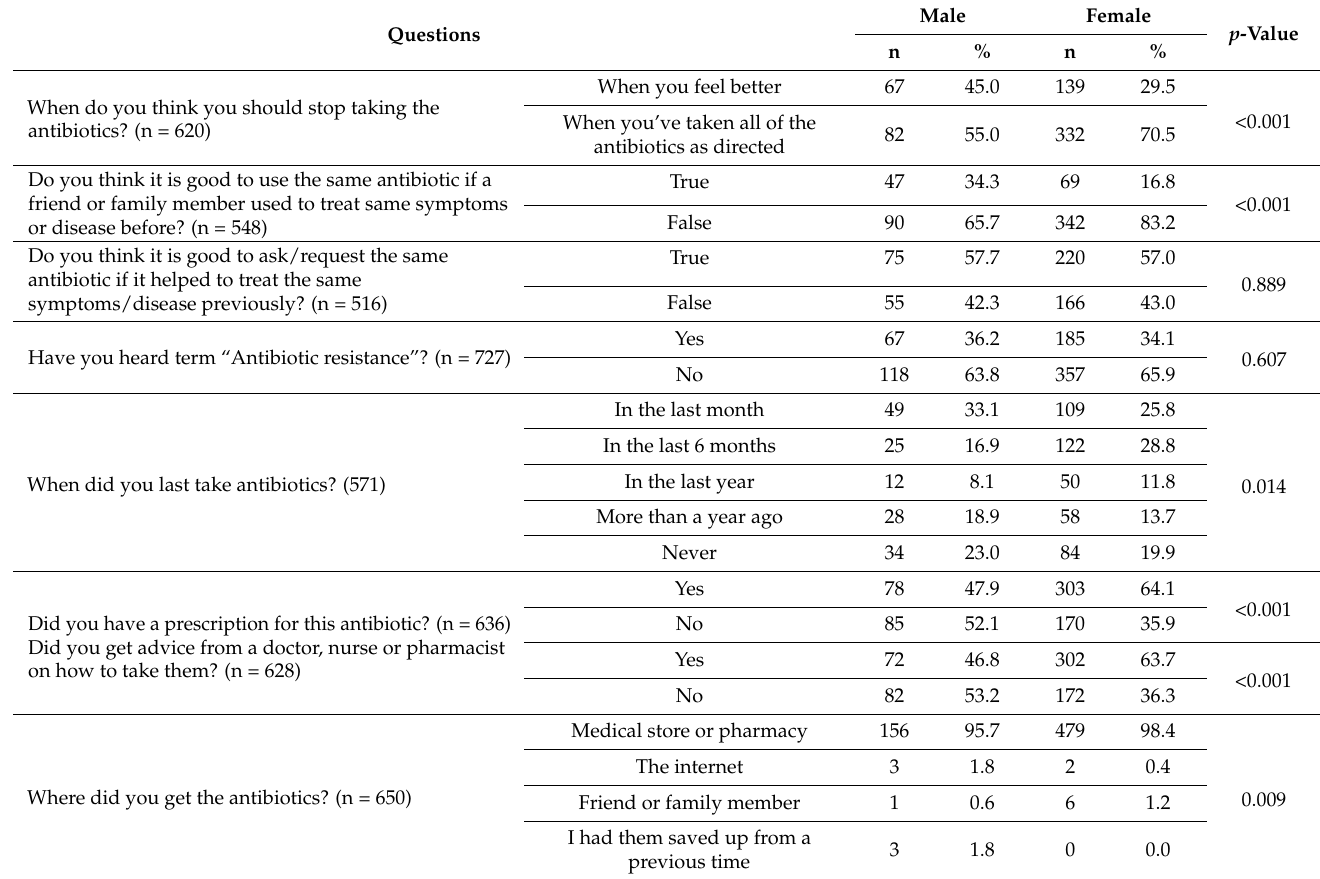
Table 2. Awareness about antibiotic use and resistance by